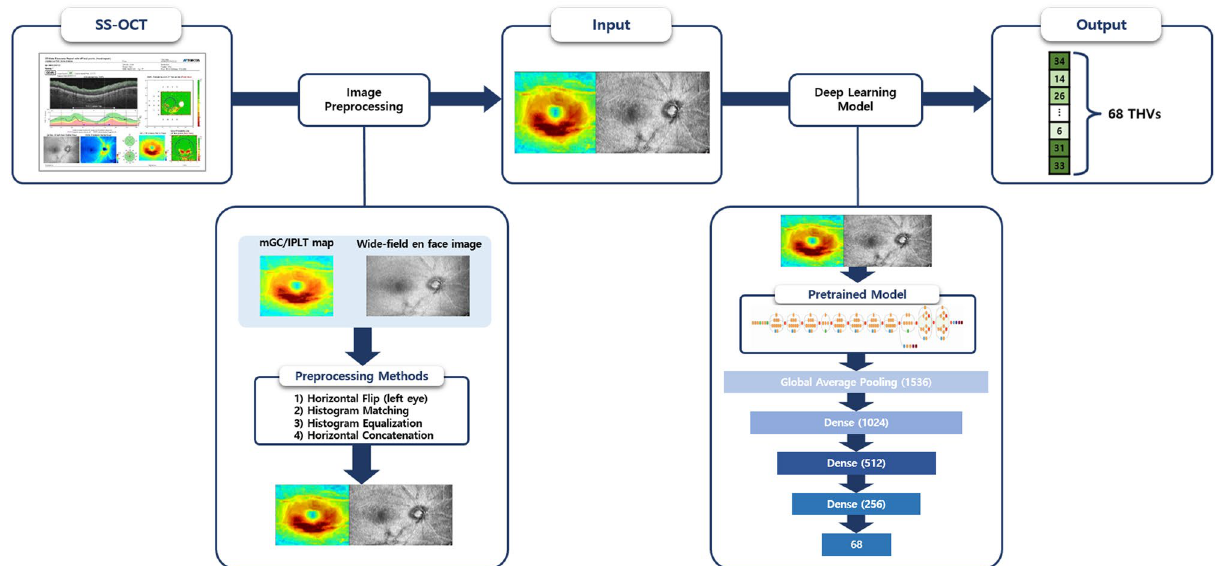
Figure 1. Flow diagram of the deep learning model (Google’s convolutional neural network architecture). Extraction of input images (wide-field en face image with mGC/IPLT map or wide-field RNFLT map with mGC/IPLT map) was performed on a wide-field scan of SS-OCT. Then, preprocessing of the extracted images was carried out, including consistency and contrast enhancement and concatenation of images. Inception- ResNet-V2 was used as the backbone structure at the beginning of the architecture to extract the global features. The global average pooling layer flattened the output of the Inception-ResNet-V2 backbone and averaged 1536 features. The three dense layers gradually condensed these features into 68 final output values, which corresponded to 68 10-2 visual field threshold values. mGC/IPLT macular ganglion cell/inner plexiform